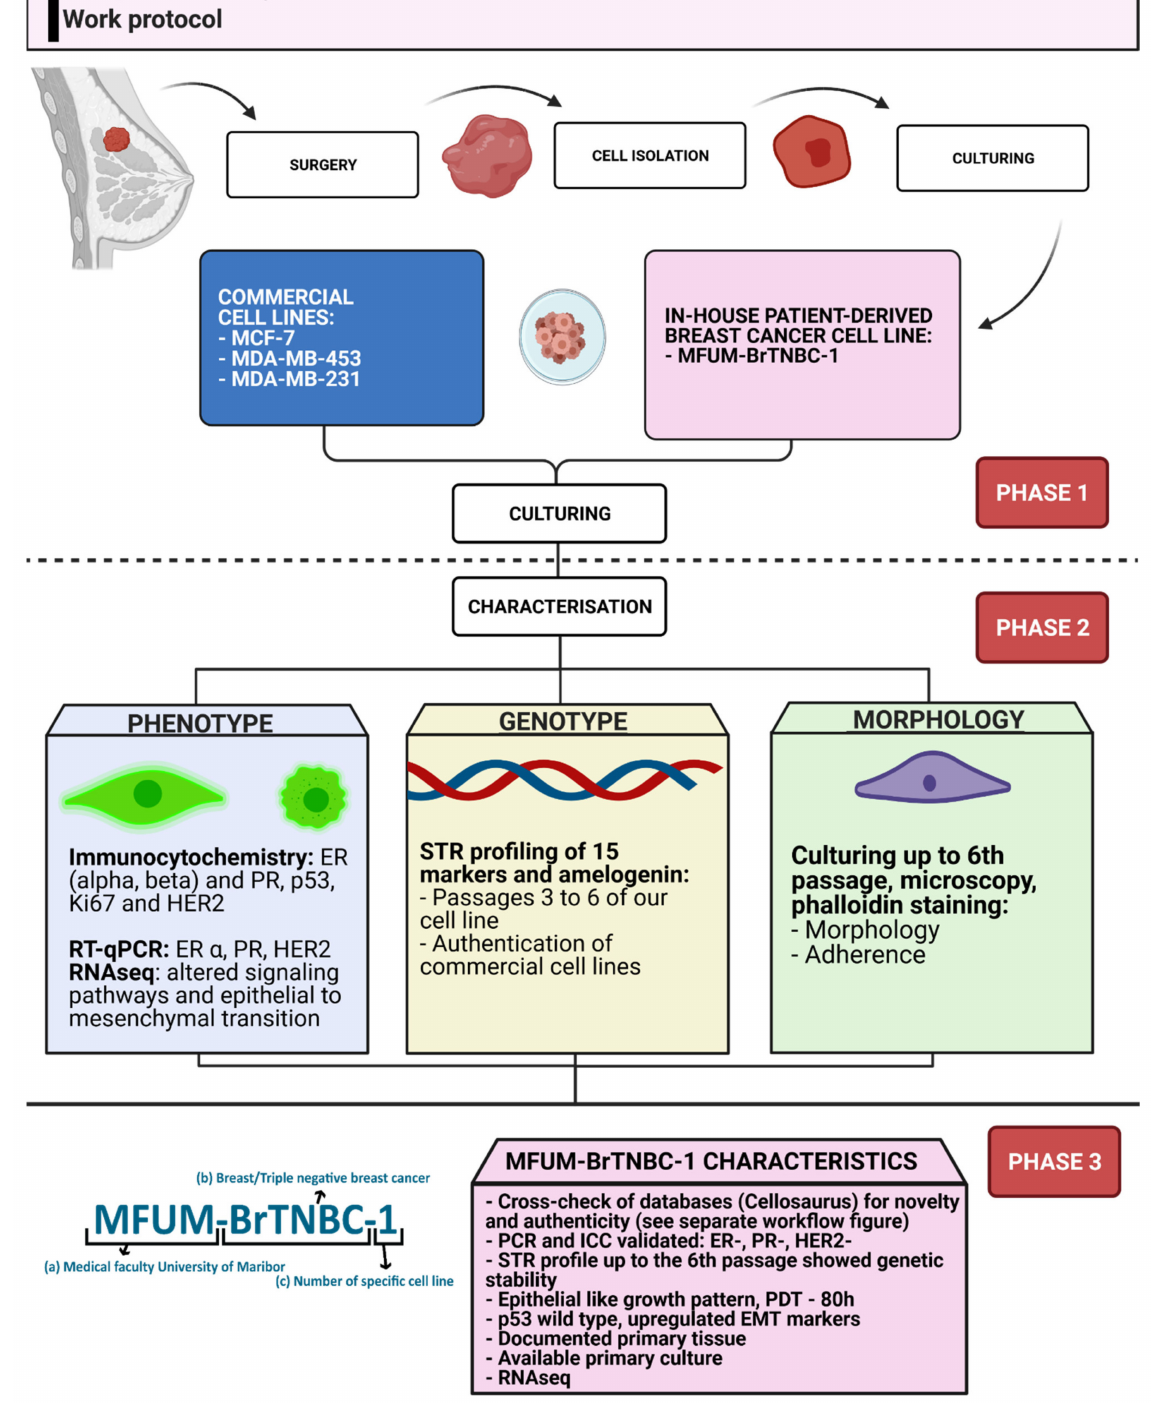
Figure 1. Work protocol of comparative CL analysis. Legend: The picture depicts a stepwise proto- col for establishing and characterising MFUM-BrTNBC-1 in adherence to international guidelines and standards. The steps include primary tissue derivation, subsequent isolation, culturing, com- parative characterisation and data analysis. ER—oestrogen receptor, PR—progesterone receptor, TNBC—triple-negative breast cancer, STR—short tandem repeat, ICC—immunocytochemistry, RT-qPCR—reverse transcription quantitative real-time